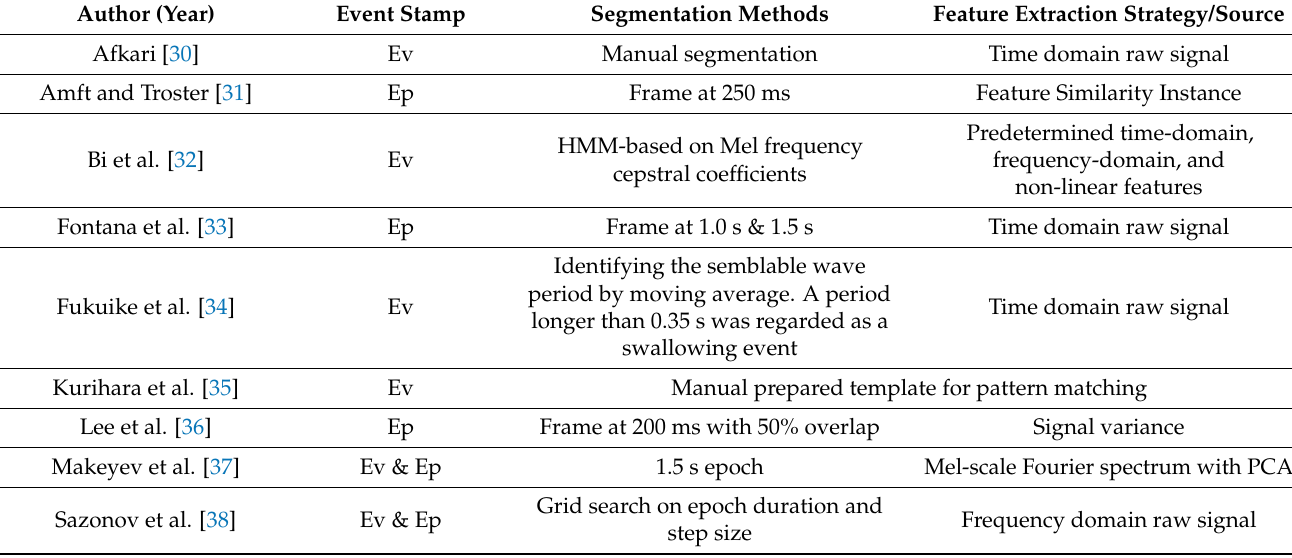
Table 3. Segmentation and Feature Extraction